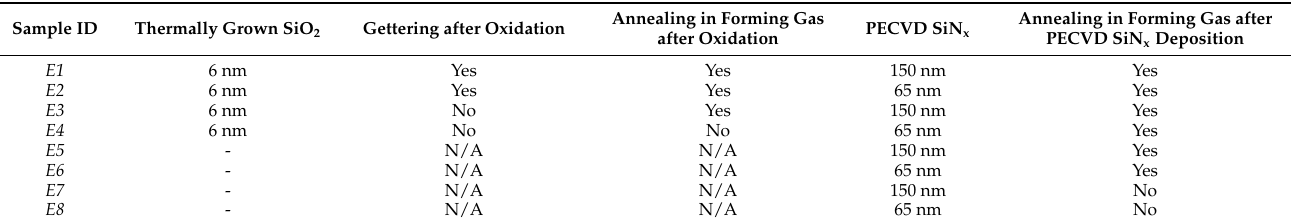
Table 1. Process description of test samples.